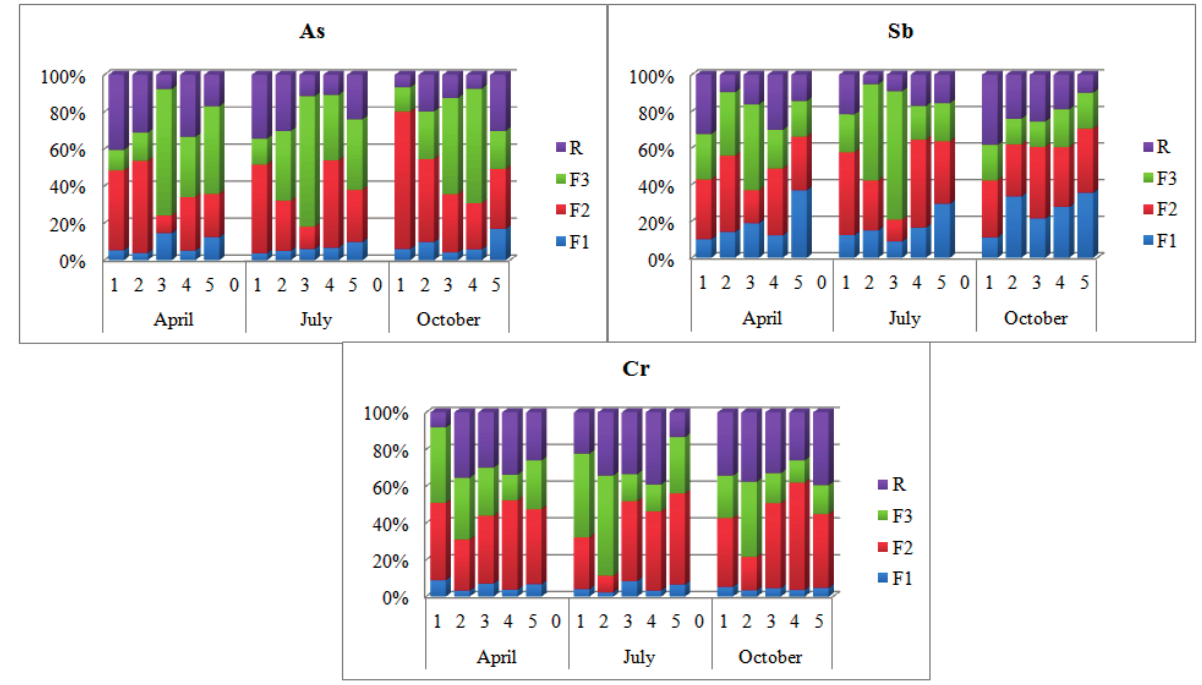
Figure 6. Simplified BCR three-step sequential extraction [15]. F1—ion-exchange and carbonate fraction; F2—oxide fraction; F3—organic and sulphide fraction; R—residual; sampling points: BP1—Chrz ą stowice; BP2—Klucze Osada; BP3—D ą browa Górnicza